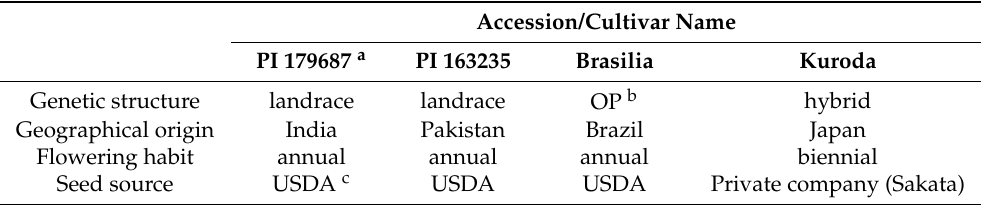
Table 2. Characteristics of the four carrot genotypes used in this study.